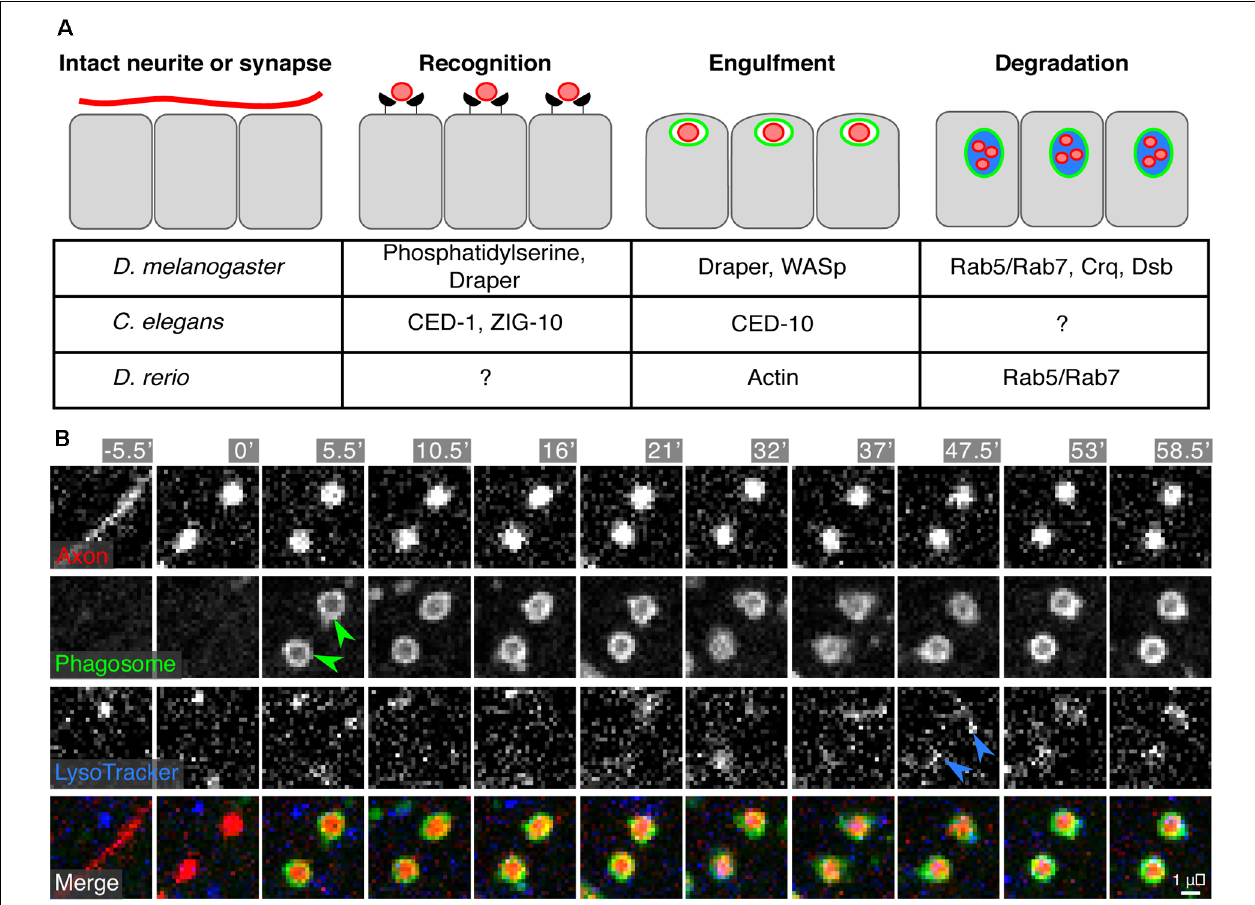
FIGURE 5 | Engulfment of synapses or neurite debris by epidermal cells. (A) A synapse to be eliminated or a damaged neurite undergoes recognition, engulfment, and degradation by the surrounding epidermal cells. The currently identified molecular machinery for these processes is listed in the table. (B) Time-lapse microscopy of engulfment and degradation of SSN axon debris by epidermal cells following axotomy in larval zebrafish. Green arrowheads indicate engulfment and internalization of axon debris [labeled by Tg(isl1[ss]:lexa;lexaop:tdTomato) ] into epidermal phagosomes [labeled by TgBAC(p63:Gal4FF) ; Tg(4 × UAS:EGFP-2 × FYVE) ]. Blue arrowheads indicate acidification of the phagosomal compartments as visualized by Lysotracker staining. Micrographs in (B) reprinted from Rasmussen et al. (2015) under the Creative Commons